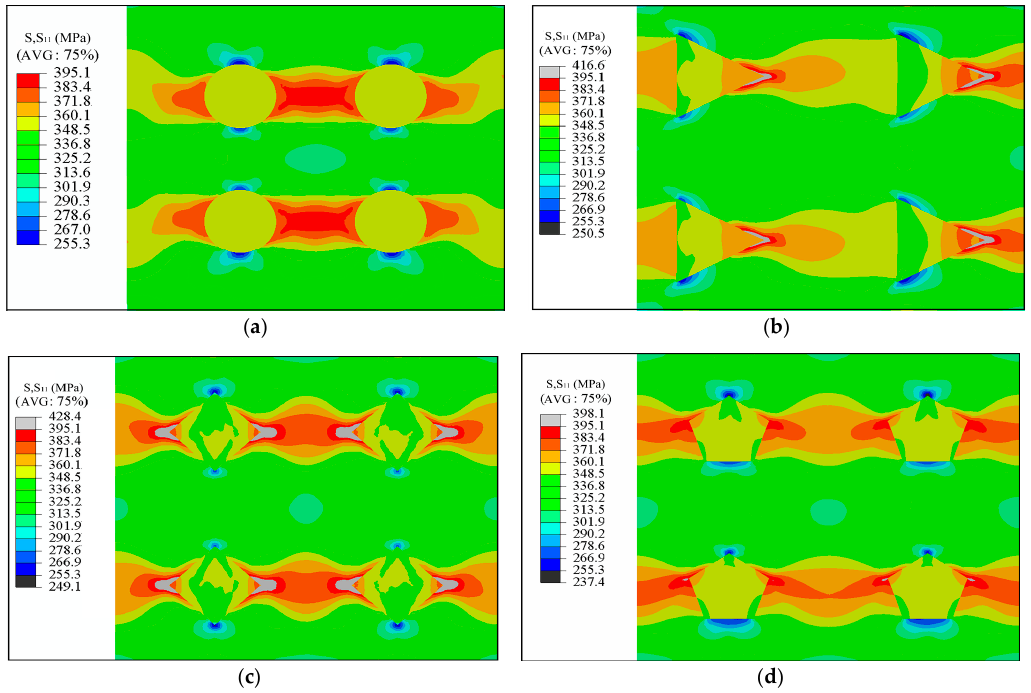
Figure 5. S 11 distribution of the composite models with different SiCp shapes: ( a ) round particle doping; ( b ) equilateral triangle particle doping; ( c ) square particle doping; and ( d ) regular pentagon particle doping.